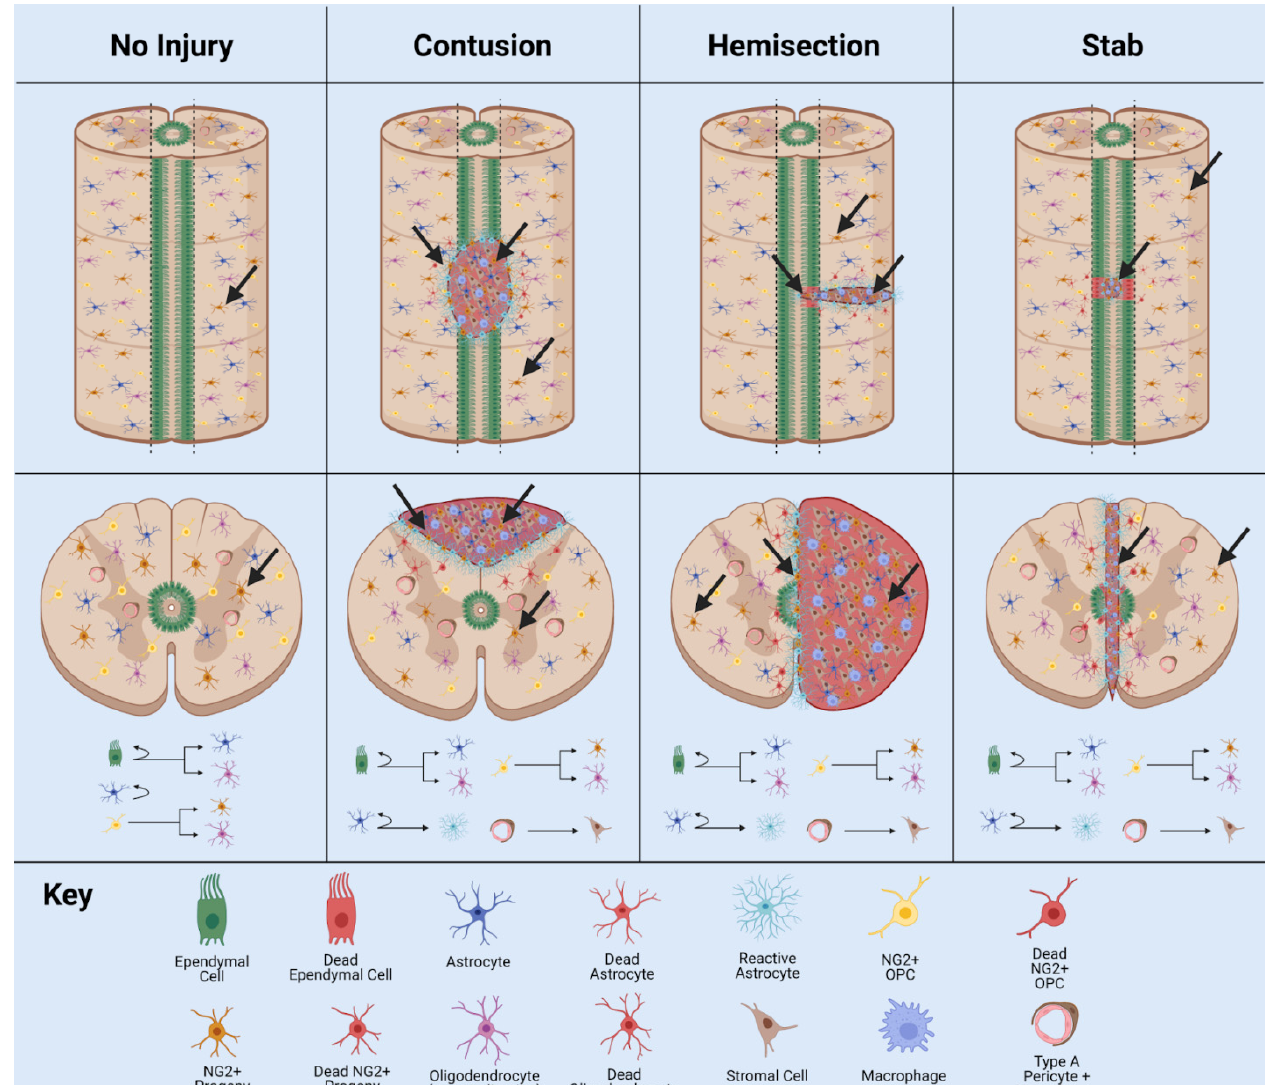
Figure 4. Behavior of ependymal cells and NG2+ cells in animal models of SCI. In normal physiology, the ependymal cells lining the wall of the central canal are largely quiescent, while NG2+ cells are ubiquitously distributed throughout the grey and white matter of the spinal cord. In contusion SCI, the ependymal cell layer is not damaged, but may increase proliferation and differentiation potential. In the hemisection model, the ependymal cell layer is damaged and ependymal cells/NG2+ cells are activated by injury. In stab SCI, the ependymal cell layer is damaged and contributes greatly to glial scar formation. Adapted from Sabelström et al., 2014 [27] , Hackett et al., 2016 [103] , and Picoli et al., 2019 [29] .